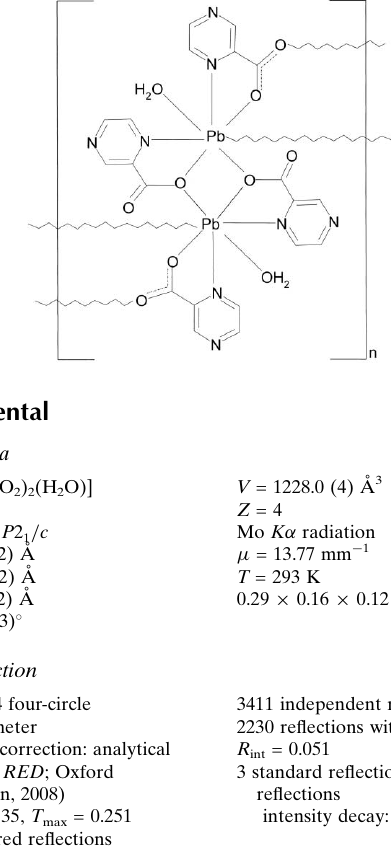
polymeric structure of the compound,